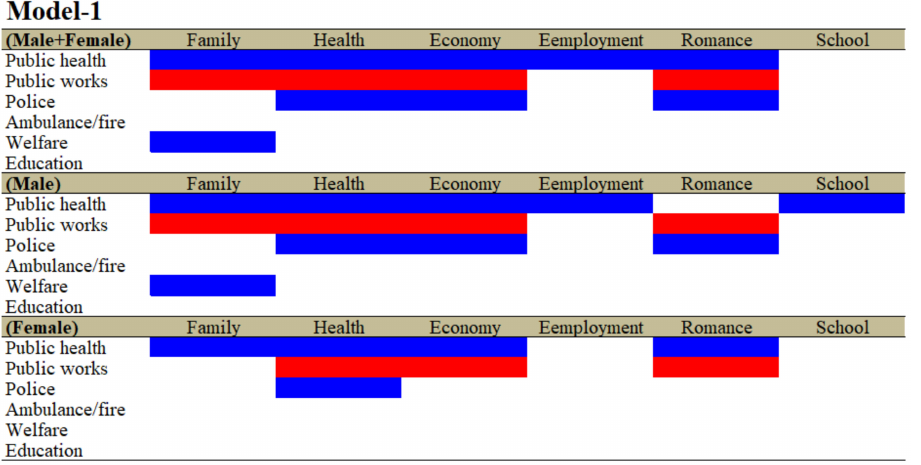
Figure 1. Relationship between total amount of financial expenditures of six major divisions (public health, public works, police, ambulance/fire, welfare and education) in prefectures/municipalities and suicide mortalities caused by six major motives (family-, health-, economy-, employment-, romance- and school-related problems) for both genders (males + females), males and females between 2009 and 2018 using fixed- or random-effect analyses of hierarchal linear regression with robust standard error. Blue and red columns denote significant factors for decreasing and increasing suicide mortalities, respectively. The detailed statistical values are presented in Supplementary Tables